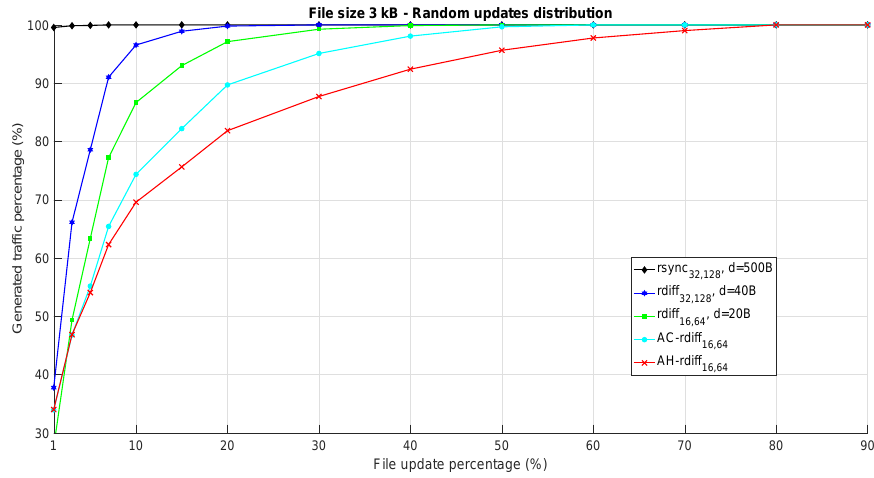
Figure 6. Performance of the considered file synchronization algorithms as a function of the file update percentage. Random update distribution within the file is